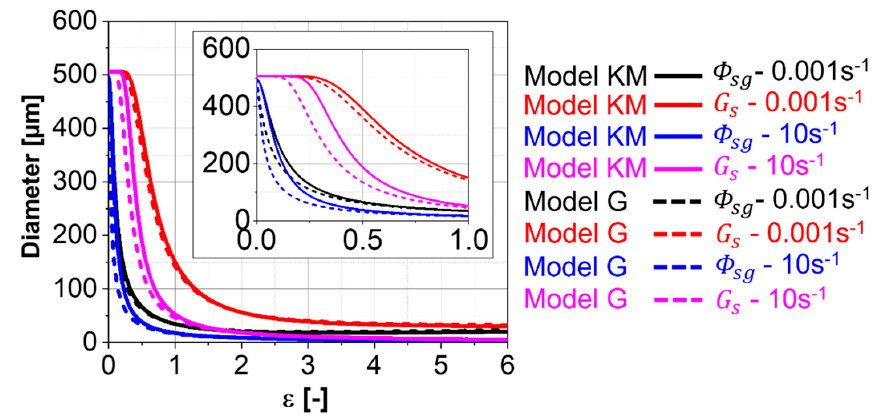
Figure 9. Simulated β -grain and β -subgrain sizes for the Ti-17 deformed at 970 °C predicted using “Model KM” and “Model G”.